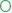
This figure shows the time-resolved influence of different protein kinase inhibitors on trehalose-elevated CRE-luc activity. Controls are represented by empty green circles (), trehalose by empty red upward triangles (), inhibitor alone by blue upward triangles () and the combination of trehalose with inhibitor by blue empty downward pointing triangles (). The inhibitors are (A) Rp-8-Br-cAMPS (1 mM), a cAMP-dependent protein kinase (PKA) antagonist (inhibited: p < 0.0001 vs. trehalose), (B) U0126 elevated: p < 0.05 vs. trehalose), an inhibitor of MEK1, the kinase that phosphorylates and activates p42/44 mitogen-activated protein kinase (p42/44MAPK) also known as Extracellular signal Regulated Kinase (“ERK”), (C) genistein (elevated: p < 0.01 vs. trehalose), an inhibitor for protein tyrosine kinases (PTK), three different inhibitors for p38, (D) GW), (E) BMS582949BMS, and (F) SB203580 (inhibited: p < 0.05 vs. trehalose), (G) the phosphatidyl-inositol-3-kinase (PI3K) inhibitor LY294002, (H) a “Jun N terminal kinase” (JNK) inhibitor SP60012 and (I) the casein kinase 1 delta and epsilon (CKId/e) inhibitor IC261. Inhibitor concentration was 10 μM if not indicated else. Shown are the mean RLU ± SEM of N = 4. ANOVA with Bonferroni post-test. Significances are trehalose vs. trehalose plus inhibitor.